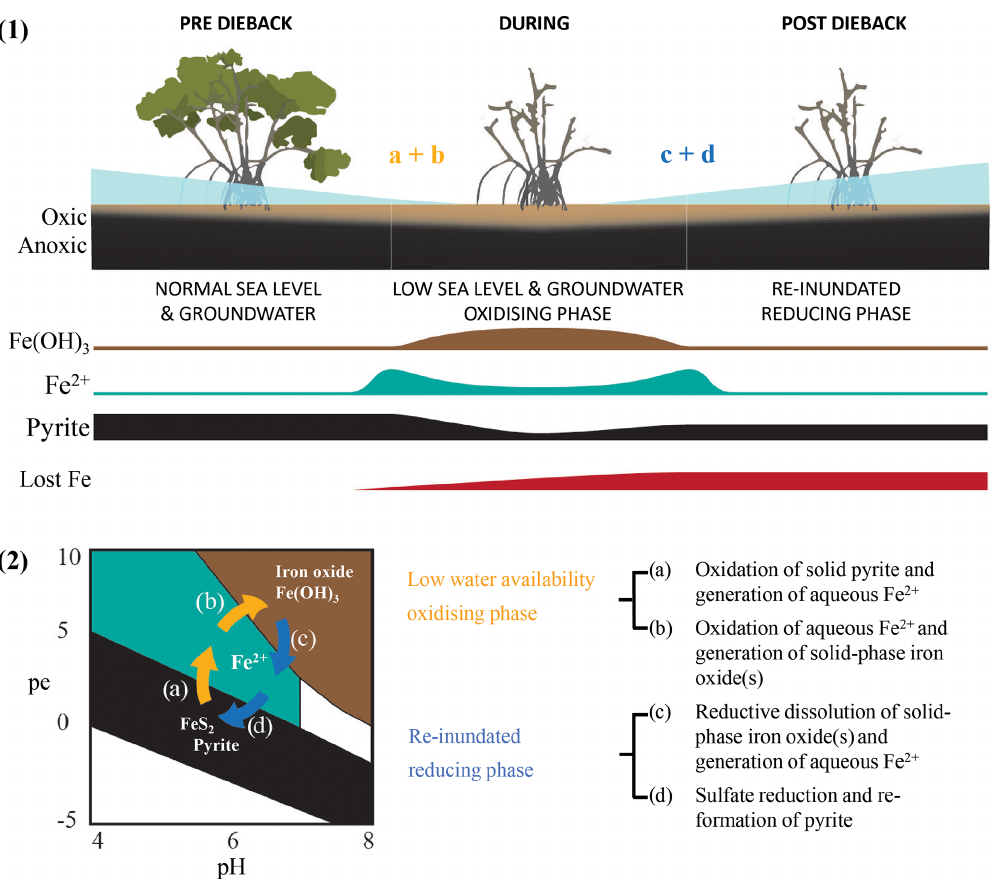
Figure 9. Conceptual diagram of Fe speciation under different sediment redox and pH conditions as well as (1) how speciation changes would be influenced by sea level and groundwater. Under initially elevated redox conditions due to low water availability (2) pyrite oxidation causes Fe transformation to (a) bioavailable Fe 2 + and (b) particulate Fe ( OH ) 3 followed by the eventual re-establishment of normal water availability and reducing conditions as well as (c) the consequent reduction of Fe ( OH ) 3 and the generation of Fe 2 + followed by (d) the sequestration of Fe(II) species via pyrite